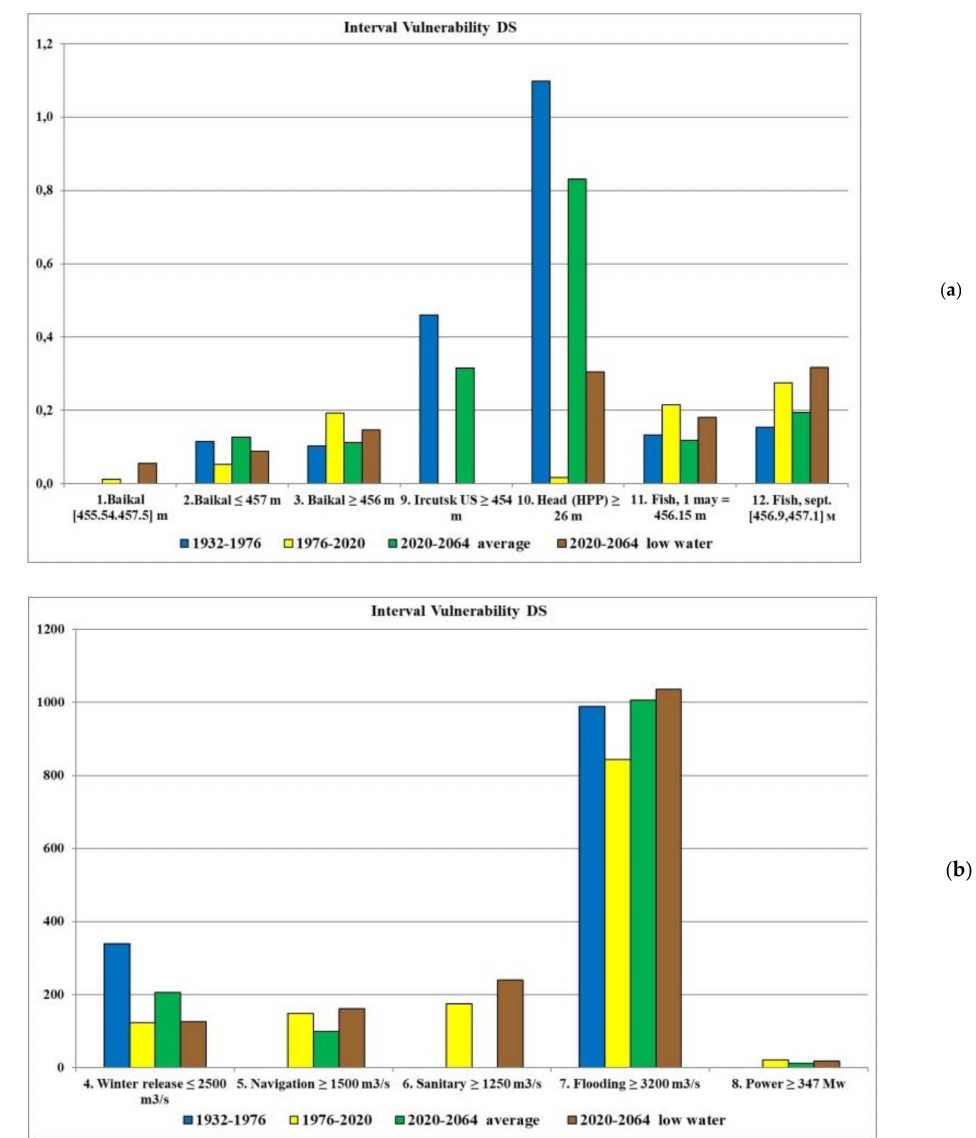
Figure 13. Vulnerability for different time series (DS) for criteria 1, 2, 3, 9, 10, 11, 12 ( a ) for criteria 4, 5, 6, 7, 8, ( b